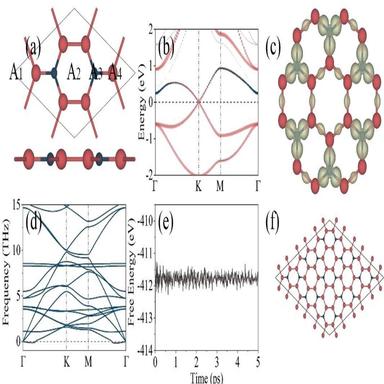
(a) Top and side views of the optimized Si3C unit cell, with dark gray (small) and brick red (big) balls representing C and Si atoms, respectively. Four possible Li adsorption sites are labeled as A1, A2, A3, A4. (b) Band structure of Si3C. The Fermi level is set to zero. (c) Charge accumulation induced by Si atoms in Si3C. (d) Phonon dispersive curves of Si3C. (e) Variation of free energies during AIMD calculations at 300 K for 5 ps for Si3C. (f) Snapshots of the final frame of Si3C monolayer at 300 K.